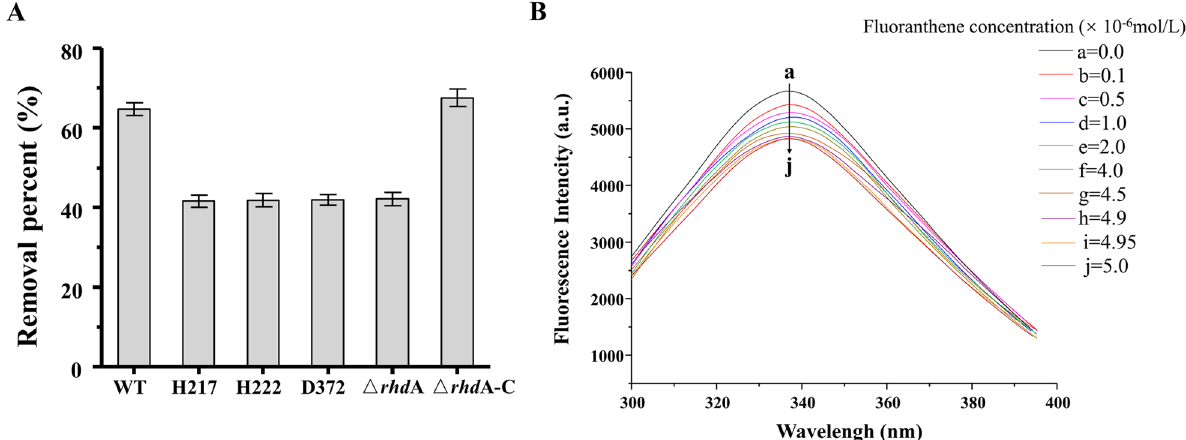
Figure 4. Degradation efficiency of wild-type DN1 and its mutants RHD aplha subunit His217 (H217), -His222 (H222), -Asp372 (D372) and alpha subunit ( △ rhd A), and the complemented strain ( △ rhd A-C) in the presence of 50 μg/ml fluoranthene ( A ). The values presented are the average ± standard deviation of experiments run in triplicate. Fluorescence quenching spectra of RHD alpha subunit under different fluoranthene concentrations (a–j) at 298 K ( B